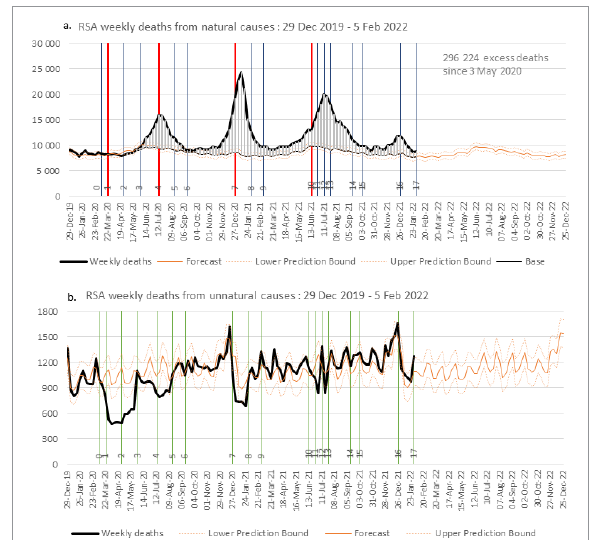
Figure 1: Weekly number of natural and unnatural deaths in South Africa, 29 December 2019 – 5 February 2022. Weekly excess natural deaths are represented by grey bars between the estimated weekly numbers and the predicted numbers. Vertical lines indicate the weeks in which material changes were made to the lockdown regulations with red lines representing a tightening of restrictions to limit the spread of infections or the impact on healthcare resources.